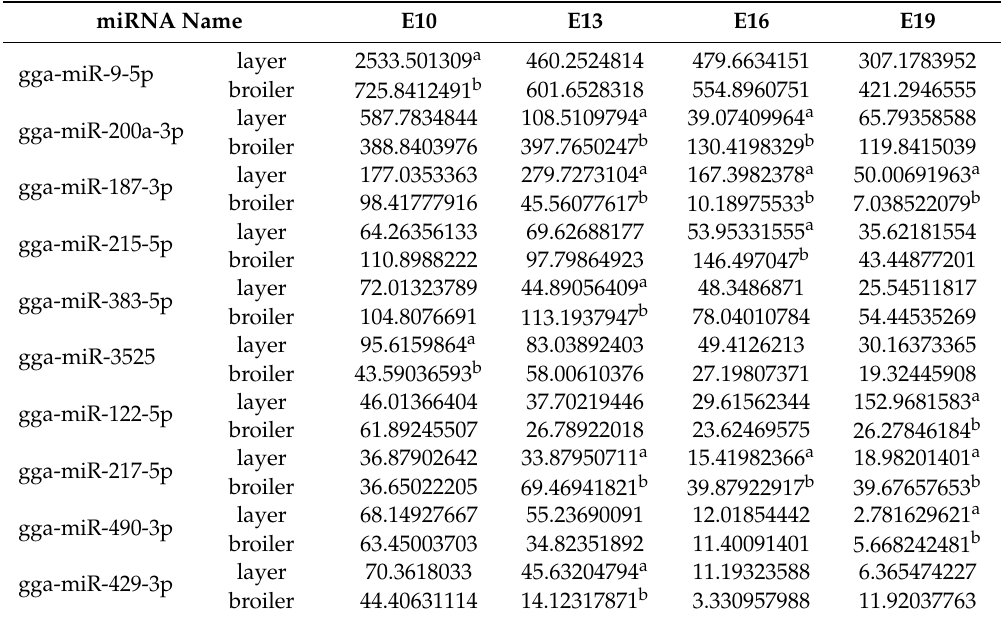
Table 2. Top 10 most highly di ff erentially expressed miRNAs (DEMs) in chicken skeletal muscle.